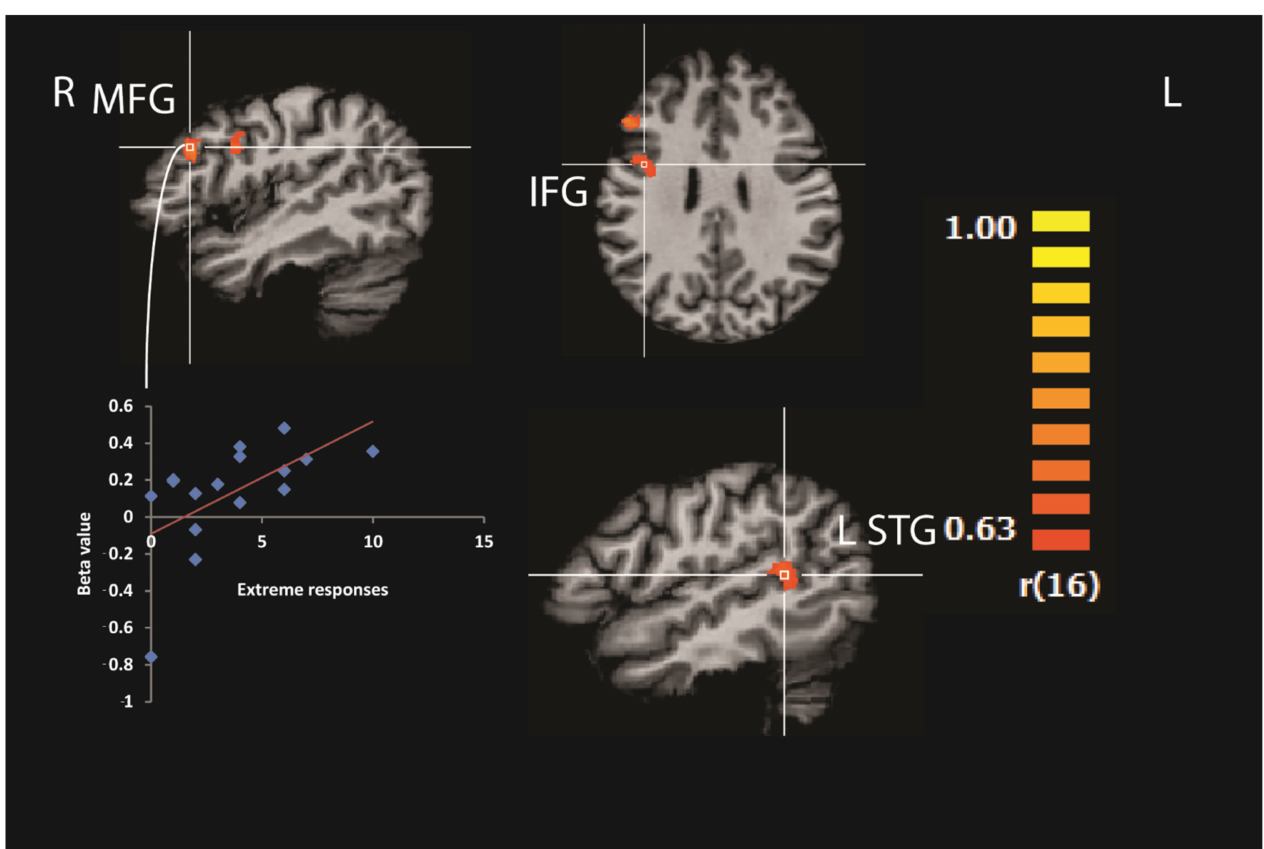
Figure 7. Correlation analysis between brain activation during cognitive estimation and extreme estimation responses. To reveal the brain regions that showed significant activation differences between the estimation categories, we calculated a whole-brain covariate model with the number of extreme CET responses. The results indicated positive correlations between the activity of the right inferior frontal gyrus (IFG), the right middle frontal gyrus (MFG), and the left superior temporal gyrus (STG) and extreme CET responses. Table 3. Brain Regions Showing Significant Correlations with Extreme Estimations (Corrected using FDR). Brodmann Brain Region